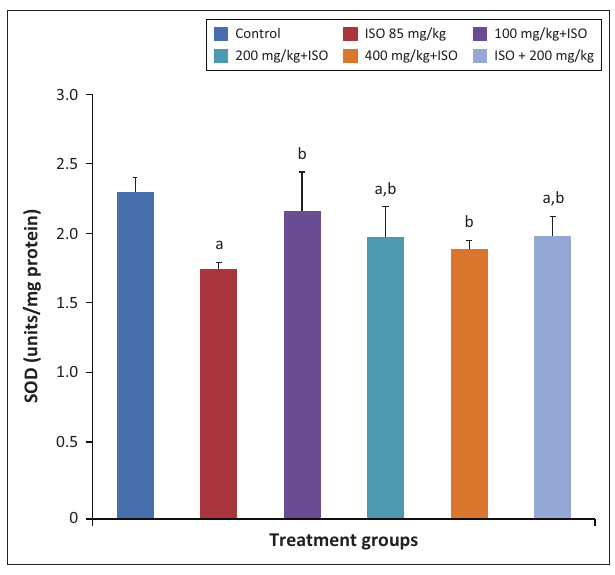
FIGURE 2: Effect of the ethanolic leaf extract of Andrographis paniculata on diastolic blood pressure (DBP) in isoproterenol-induced myocardial infarction using rats as a model.